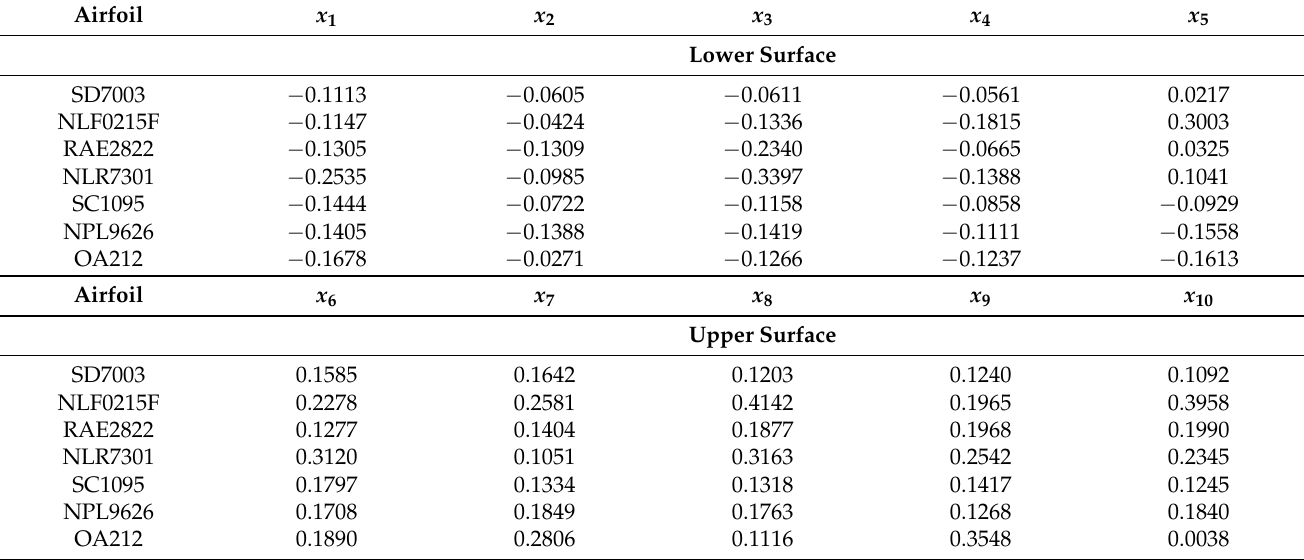
Table 1. The components of vector x corresponding to the specific airfoils.